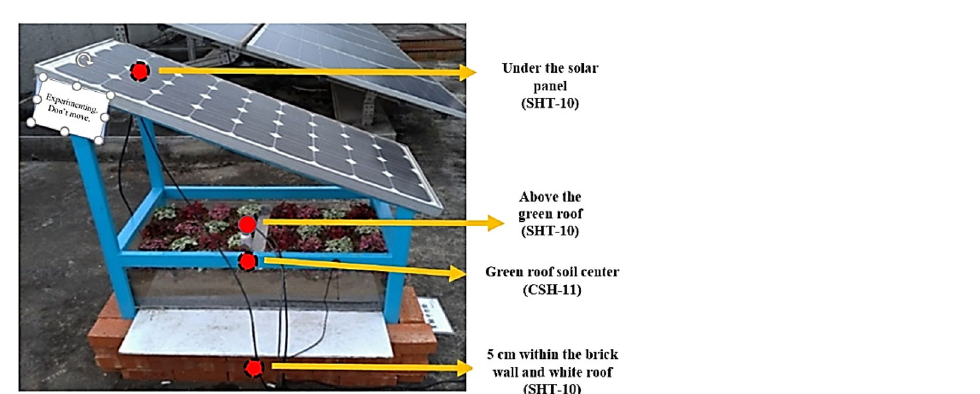
Figure 6. Placement of sensors on the green energy